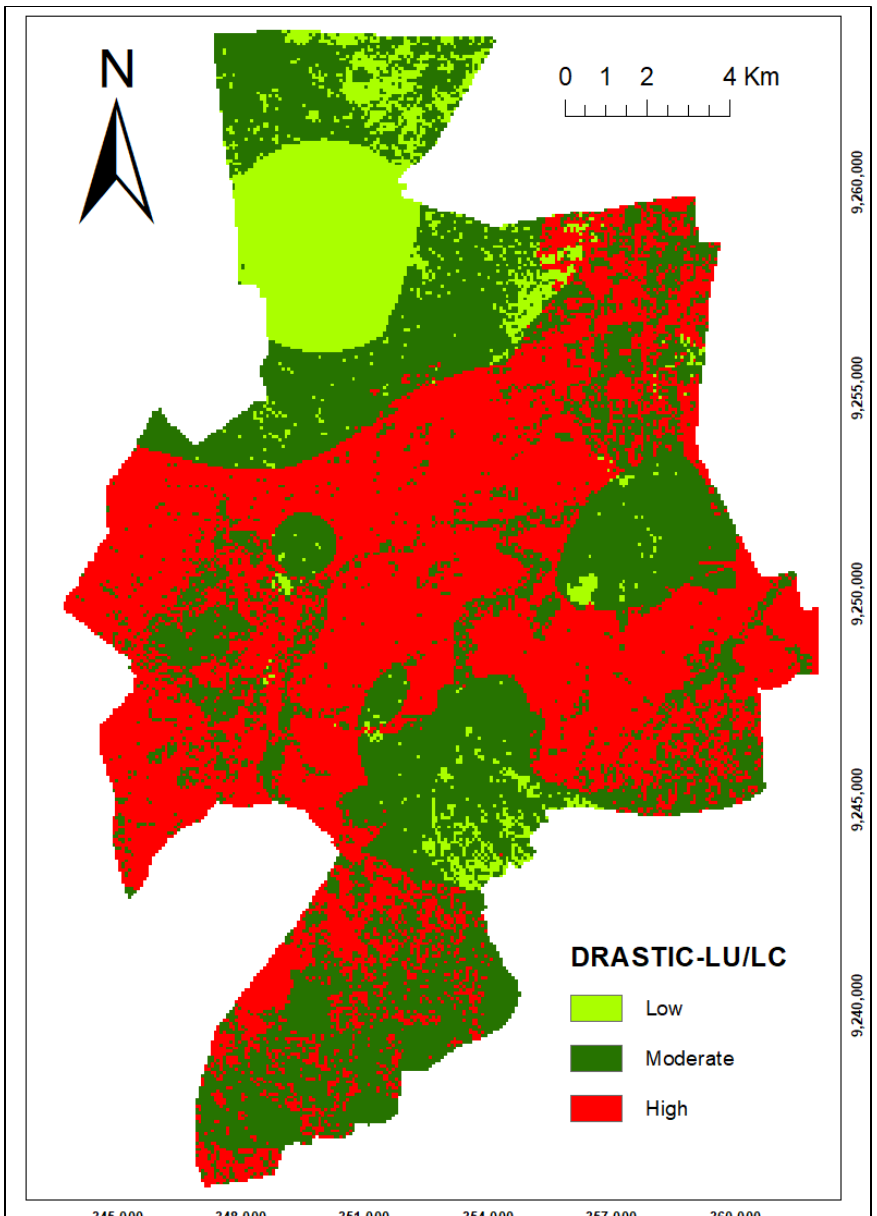
Figure 12. The DRASTIC-LU/LC model of the study